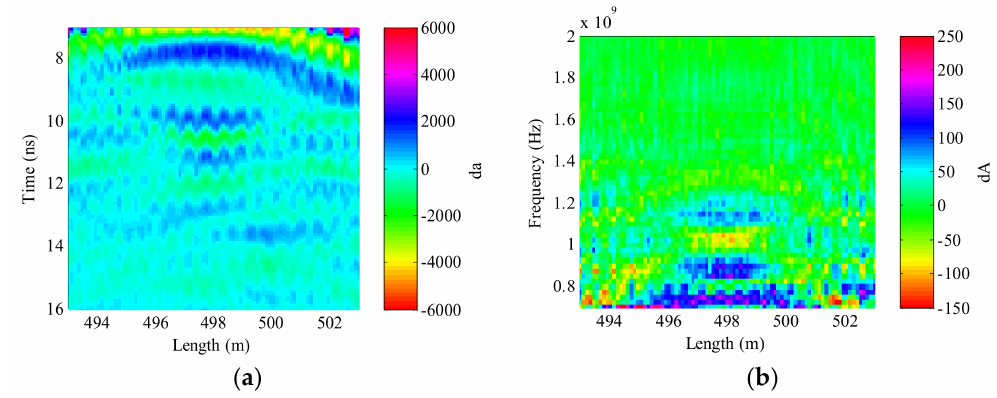
Figure 6. Example of spectrograms calculated as the difference between A S and A L , m : ( a ) in the time, da , and ( b ) in the frequency, dA , domains.